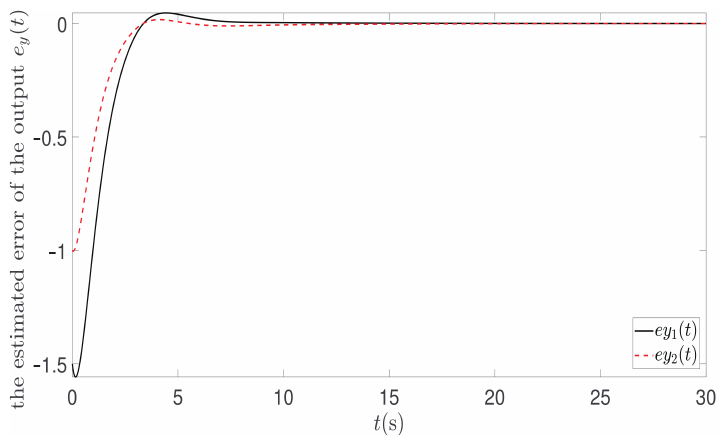
Figure 18. The error curves of the